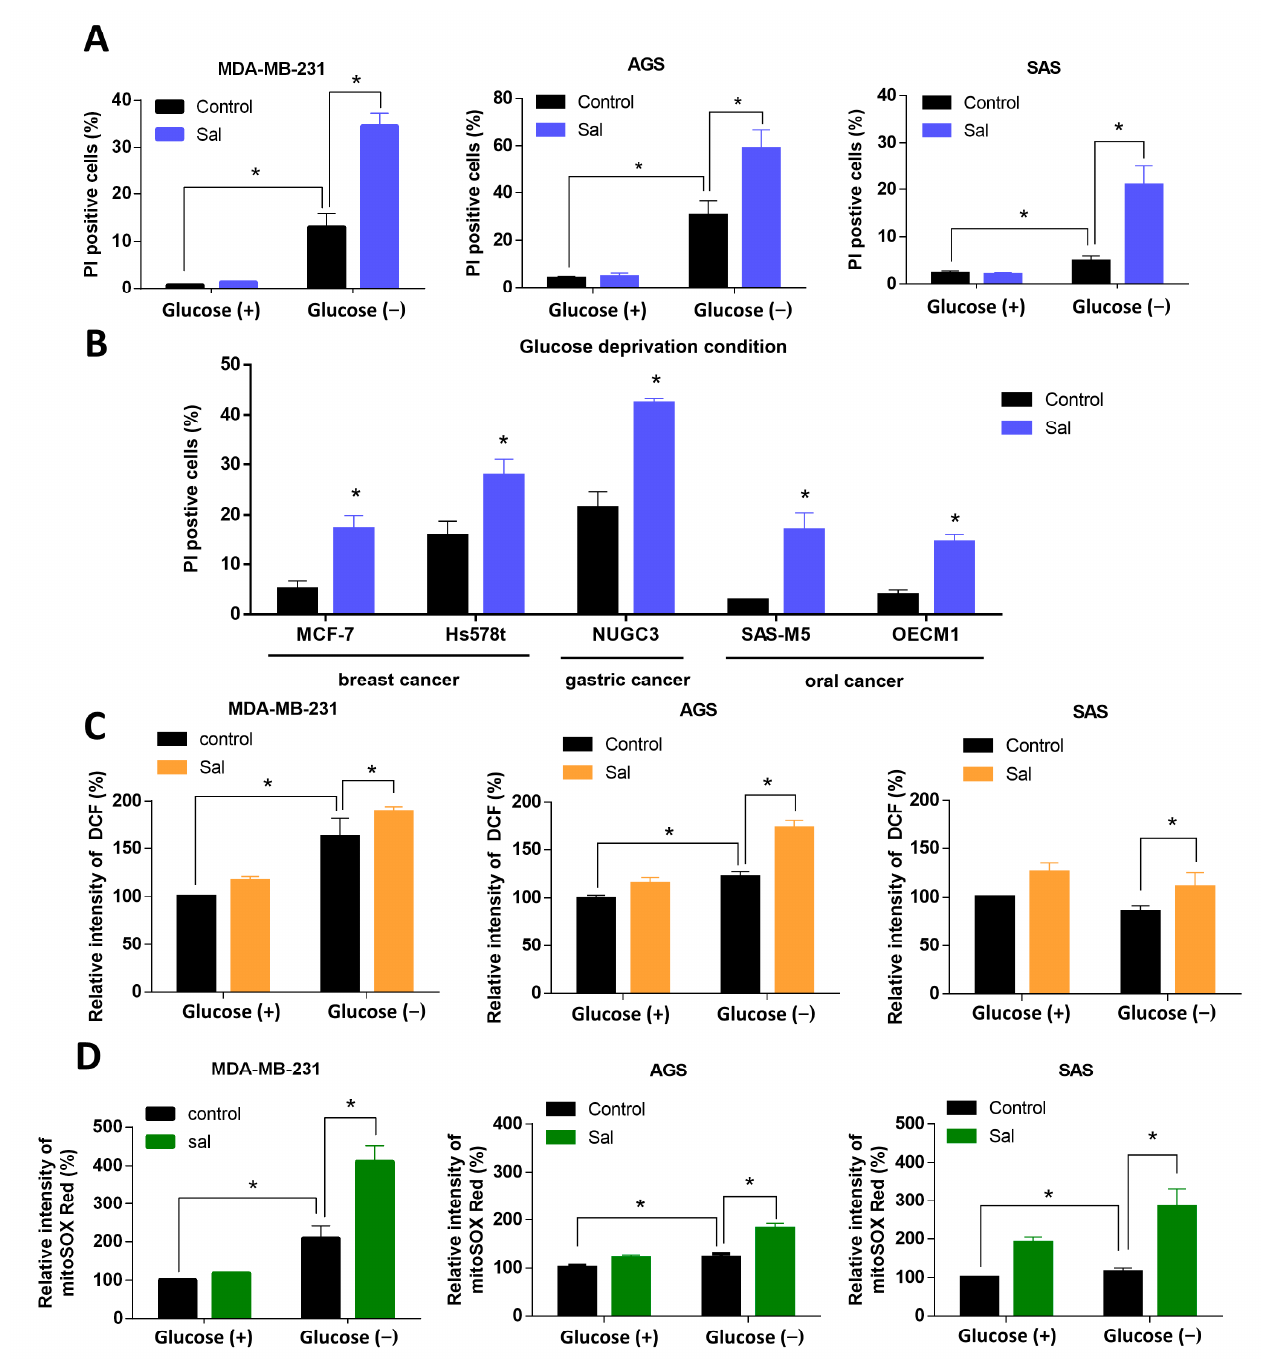
Figure 2. Salubrinal enhanced glucose deprivation-induced cell death and ROS levels. The cells were treated according to the study design with or without 30 µ M of salubrinal for 24 h except for 48 h in OECM1. ( A , B ) The cell death rate was evaluated by a propidium iodide (PI) exclusion assay in MDAMB-231, AGS, and SAS cells ( A ), as well as in other cell lines during glucose deprivation ( B ). ( C , D ) The levels of intracellular ROS (icROS) and mitochondrial ROS (mtROS) were detected using flow cytometry with DCFH-dA staining ( C ) and mitoSOX Red dye ( D ). The measured value of ROS from the control group under glucose-containing conditions was normalized to 100%. The data are presented as the means ± SEMs of the results from three independent experiments. * p < 0.05. Sal: salubrinal. Glucose (+): medium with 25 mM of glucose. Glucose ( − ): glucose-free